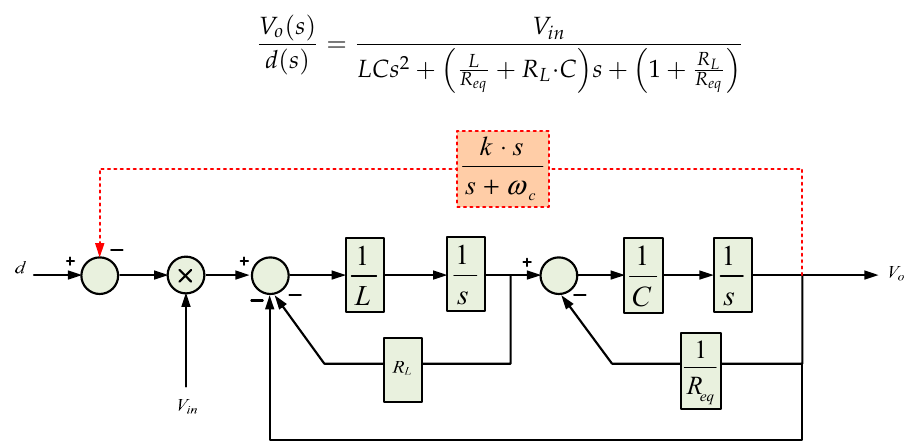
Figure 9. Block diagram representation of the buck converter with CPL [86].